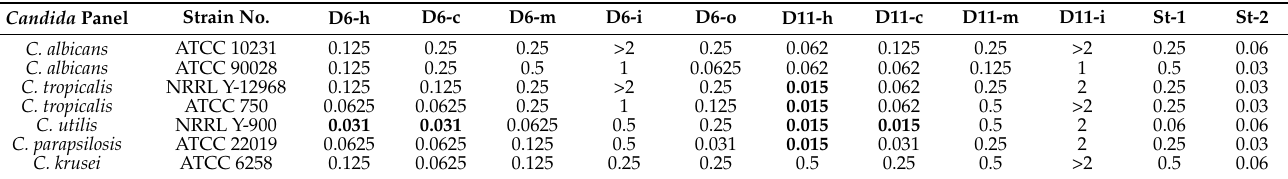
Table 5. Anticandidal effects of the samples (MIC, µ